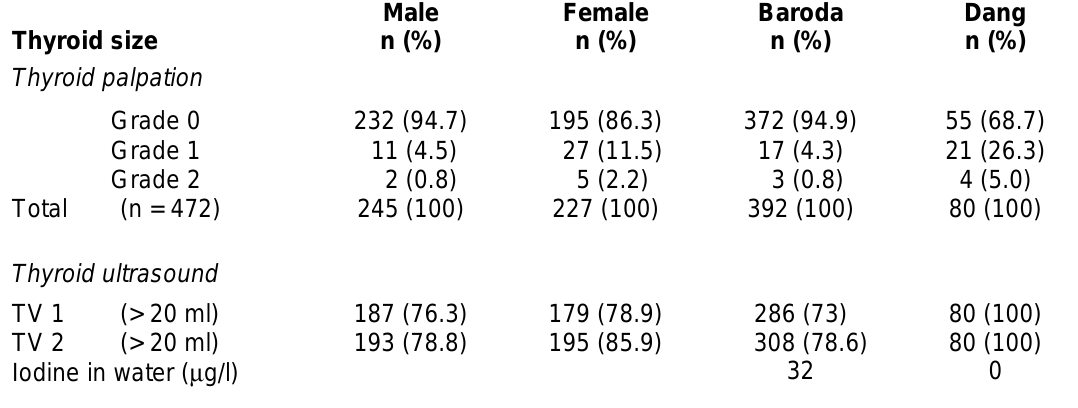
Thyroid Size as Determined by Palpation (WHO Classification) vs. Ultrasound Thyroid size